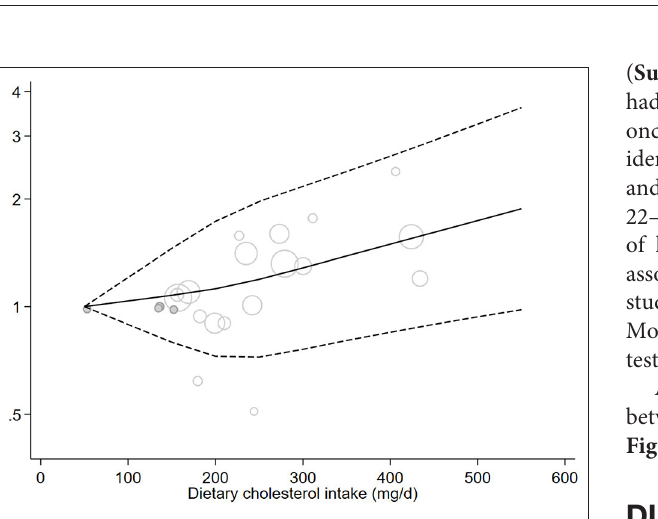
FIGURE 3 | Forest plot derived from random-effects meta-analysis of studies investigating the association between 100 mg/d increment in cholesterol intake and gastric cancer in adults. CI, confidence interval; ES, effect size.